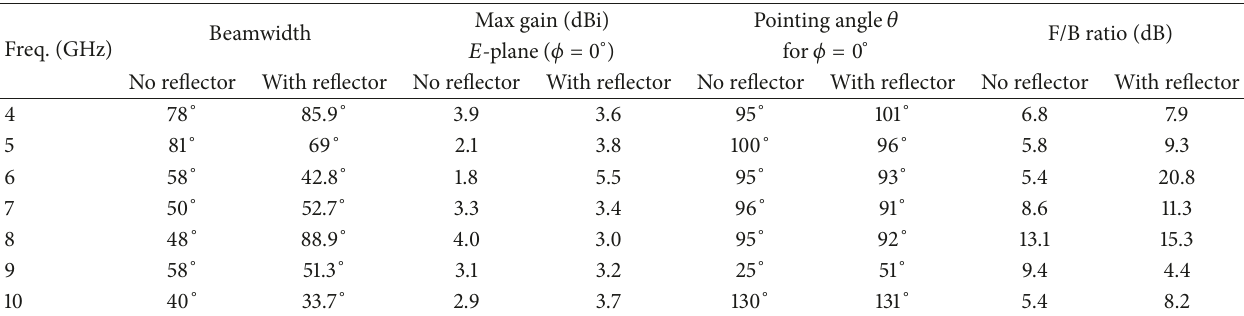
Table 2: Parameters describing the radiation characteristics of the